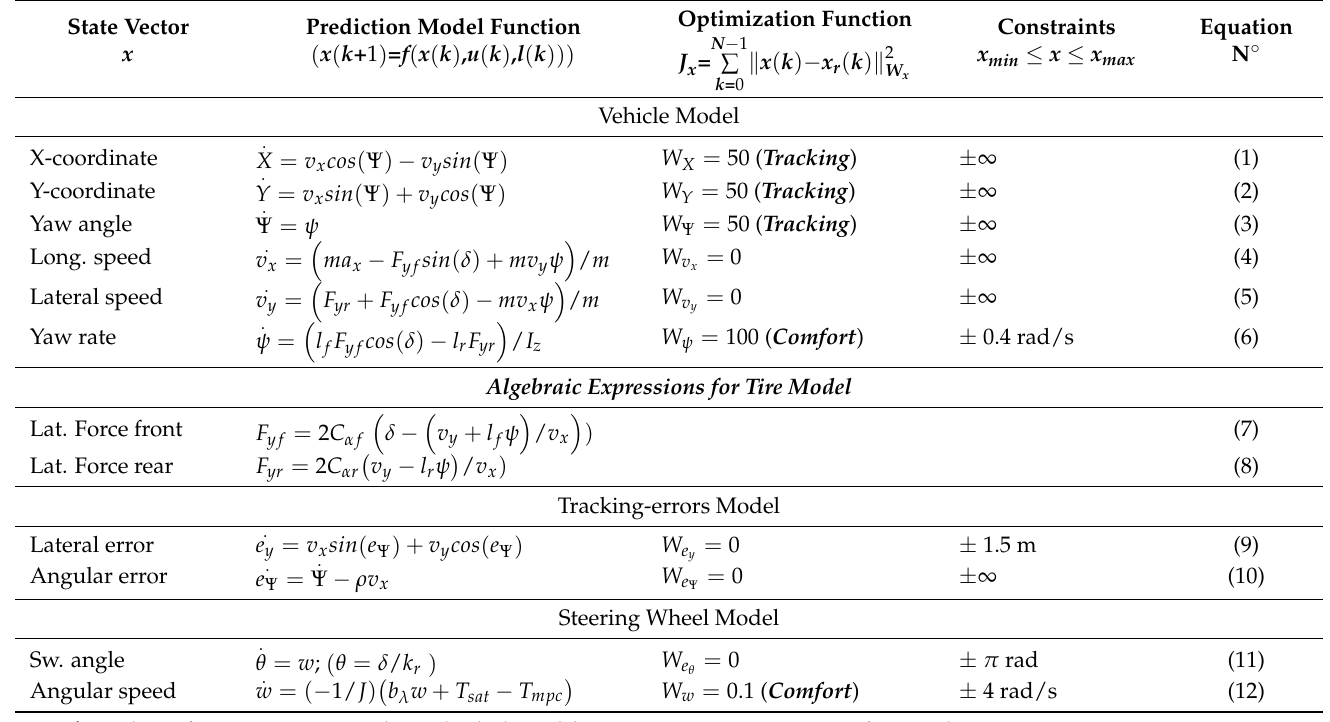
Table 2. NMPC formulation for adaptive co-pilot (system states).